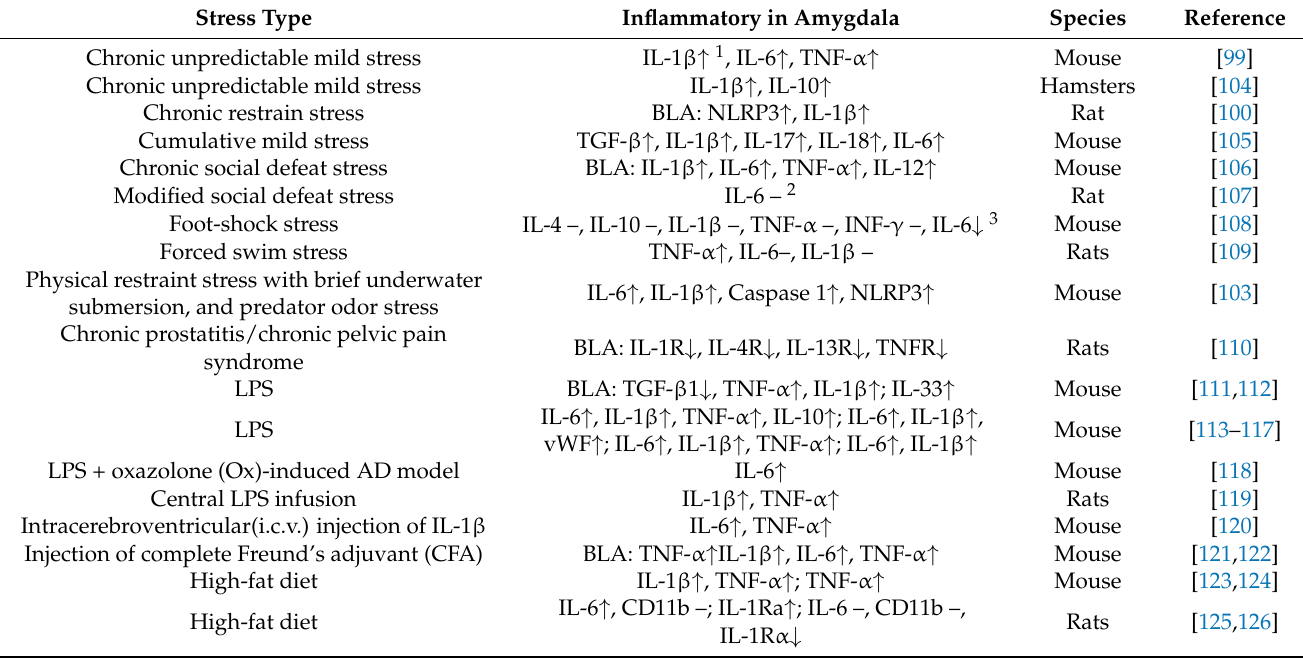
Table 1. Effects of stress on inflammatory cytokines in the